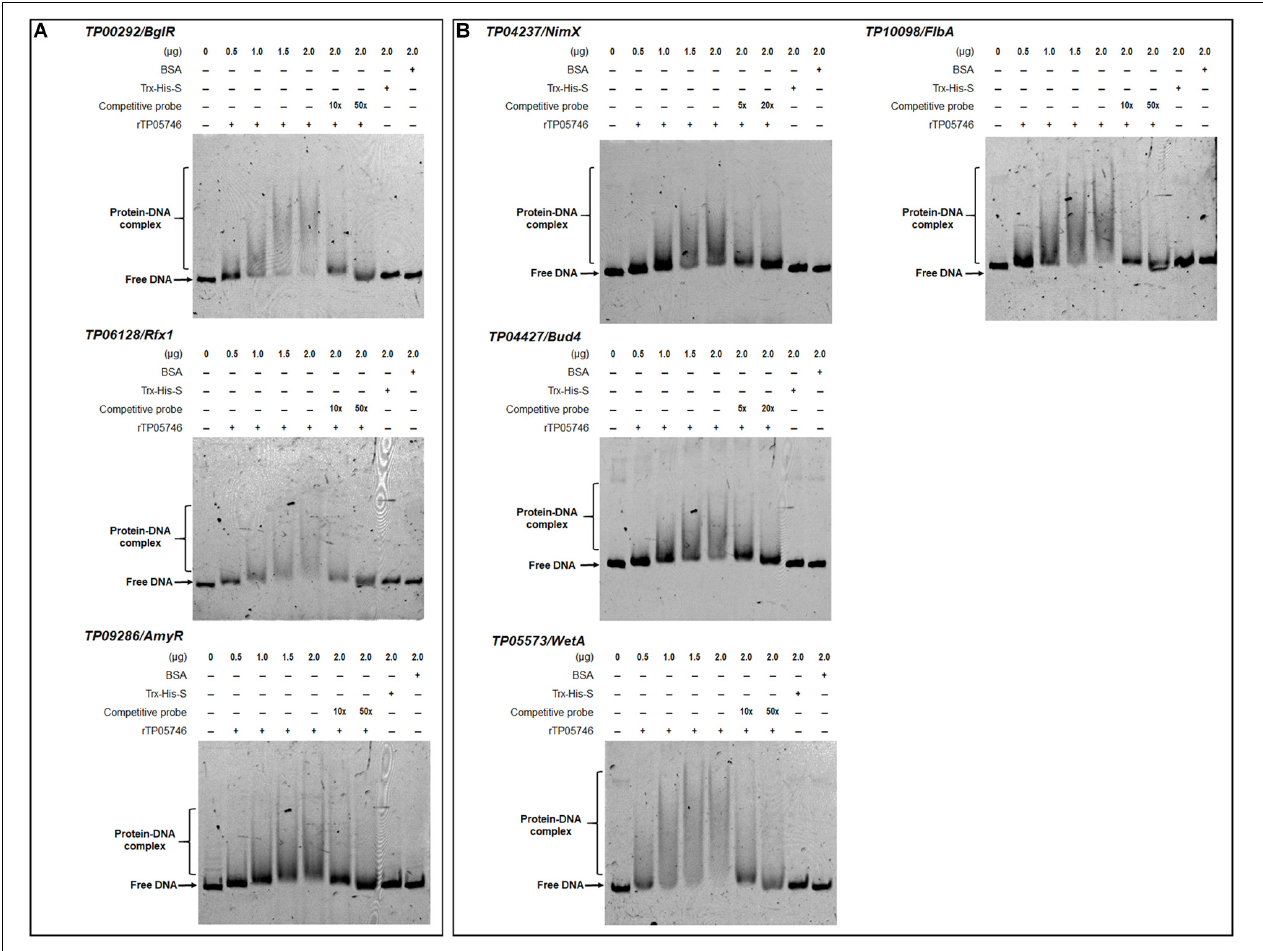
FIGURE 9 | Interaction between TP05746 and regulatory genes revealed by electrophoretic mobility shift assay (EMSA). (A) Genes involved in the regulation of PBDE gene expression. (B) Genes involved in conidiogenesis. The recombinant protein rTP05746 (0–2.0 µ g) was mixed with approximately 50 ng of FAM-labeled EMSA probes. EMSA probes lacking the FAM label were used for competitive EMSA. BSA, Trx-His-S fusion protein or the promoter region of the β -tubulin gene alone were used as controls. FAM, 6-carboxyfluorescein; EMSA, electrophoretic mobility shift assay; BSA: bovine serum albumin; PBDE,